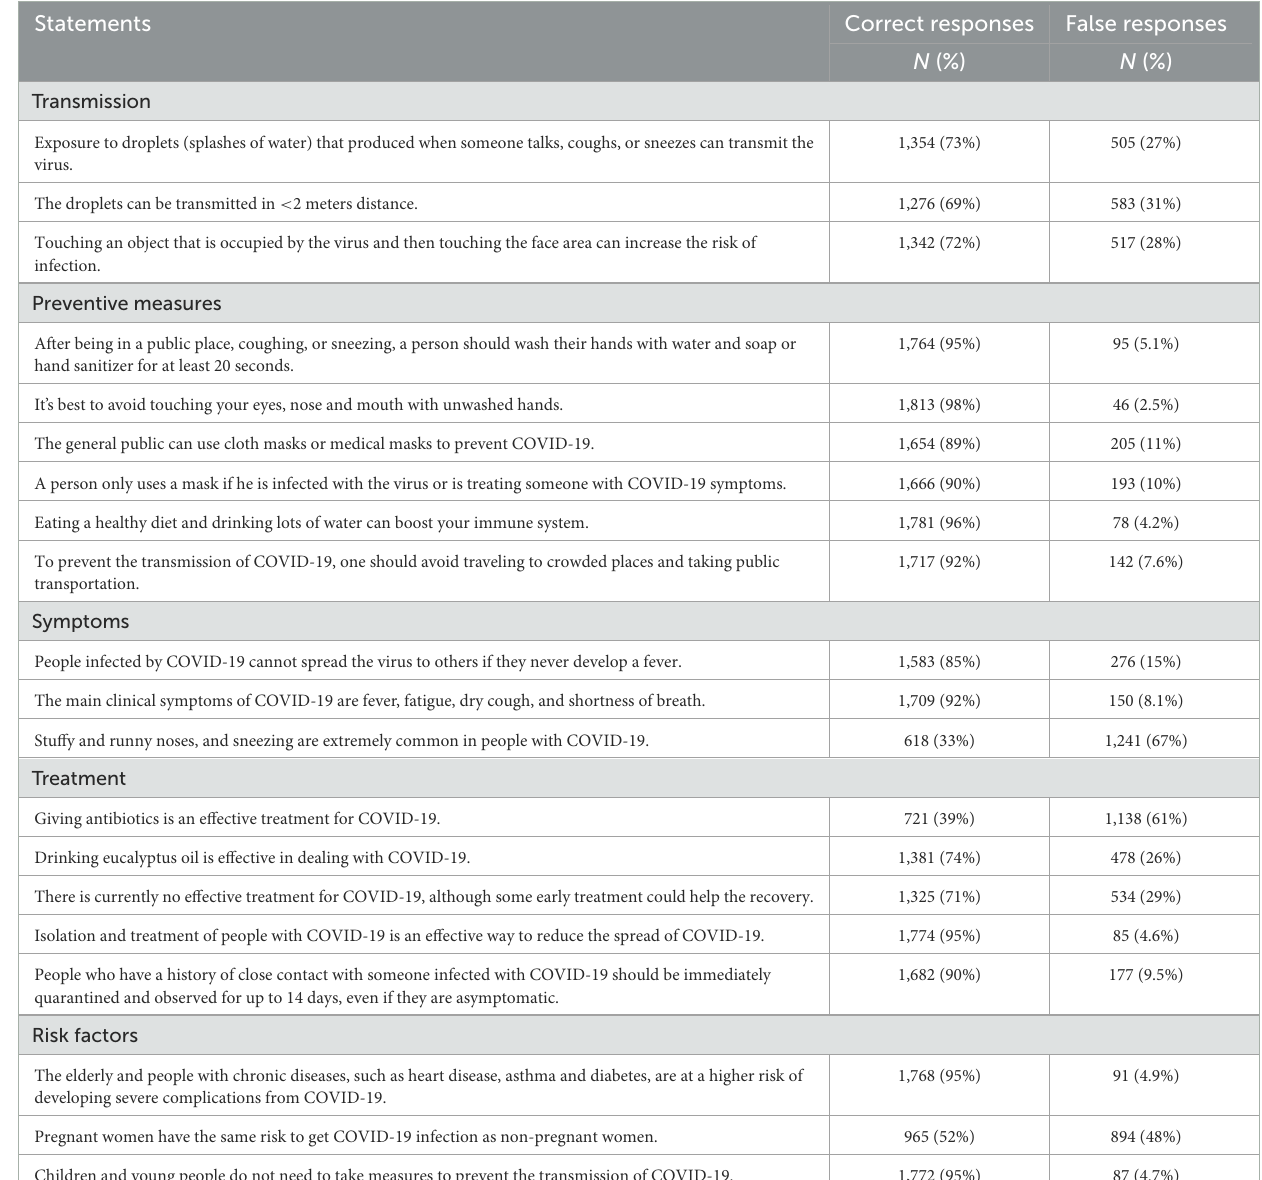
TABLE 2 Knowledge response to COVID-19 in